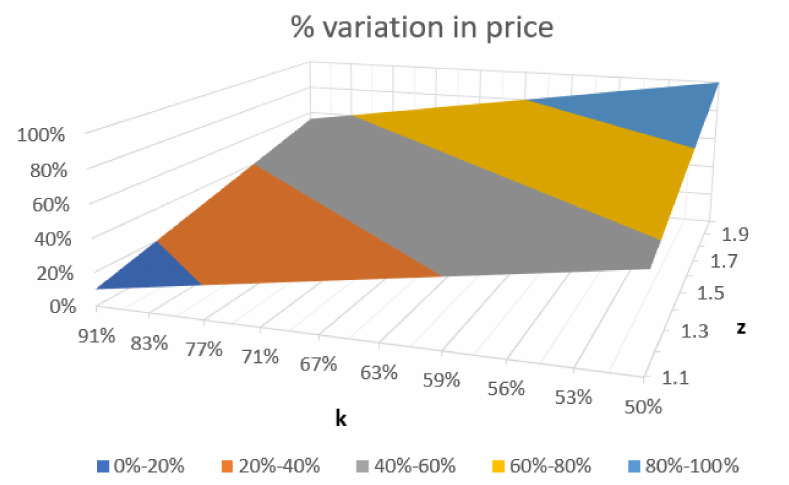
Figure 4. Percentage variation in dental charges of varying an increase in costs ( z ) and a reduction in the number of treatments ( k ), keeping the markup unchanged ( p = 200 monetary units; c = 100 monetary